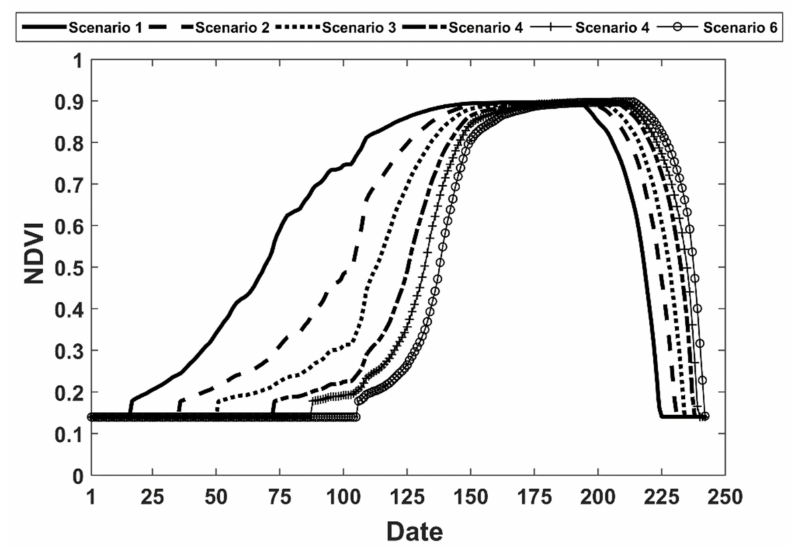
Figure 7. Example of the simulated NDVI profiles for one single plot.